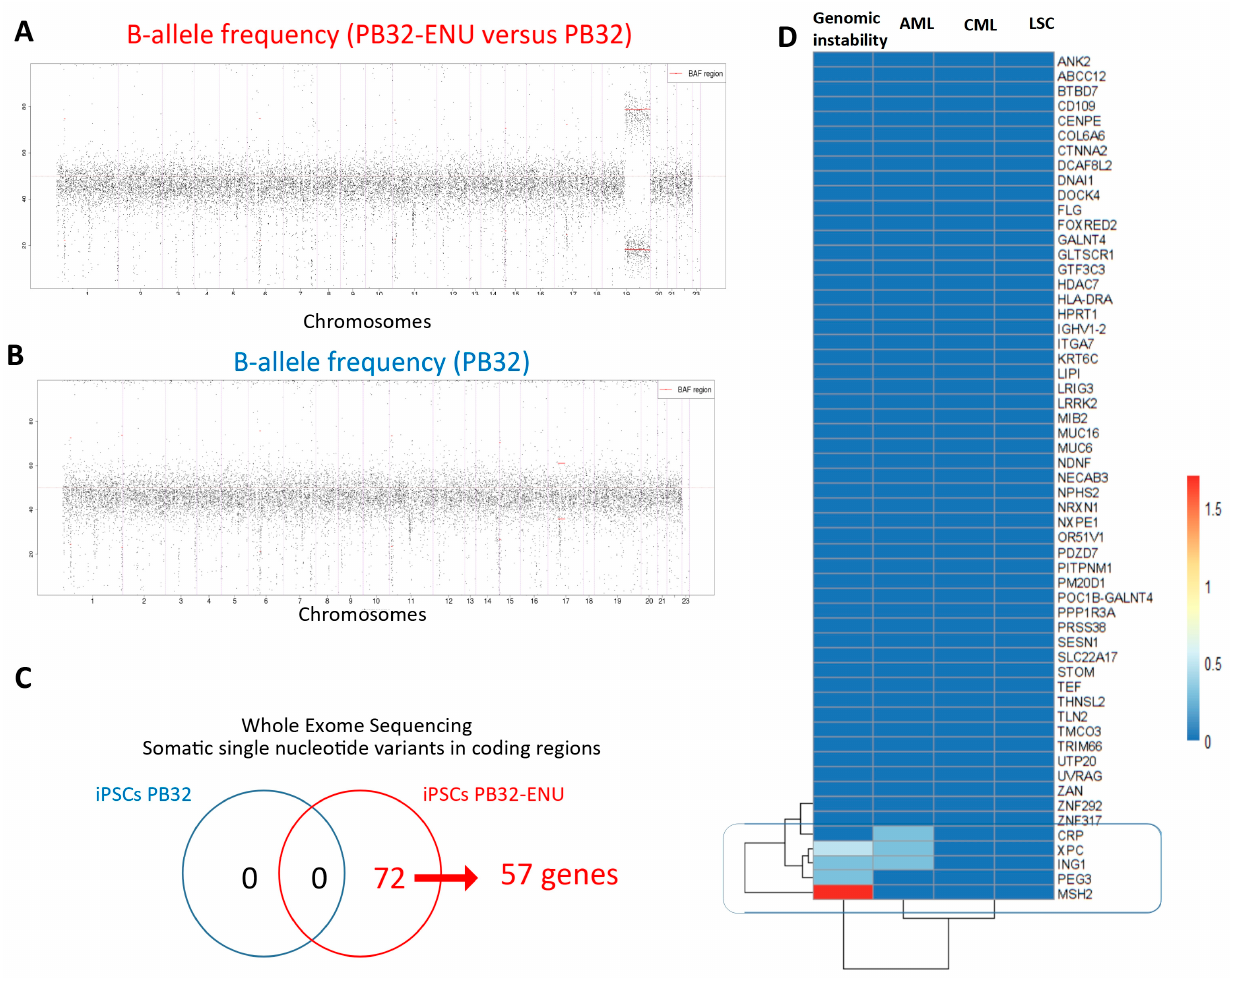
Figure 1. Whole exome sequencing of PB32 in the context of ENU treatment. ( A ) B-allele frequency plot all over human autosomes of PB32. ( B ) B-allele frequency plot all over human autosomes comparing PB32-ENU versus PB32. ( C ) Venn diagram of single nucleotide variations (SNV) found in PB32-ENU versus PB32. ( D ) Pubmed text mining citation heatmap highlighting genes affected by SNV and known to be implicated in genomic instability-related functions.